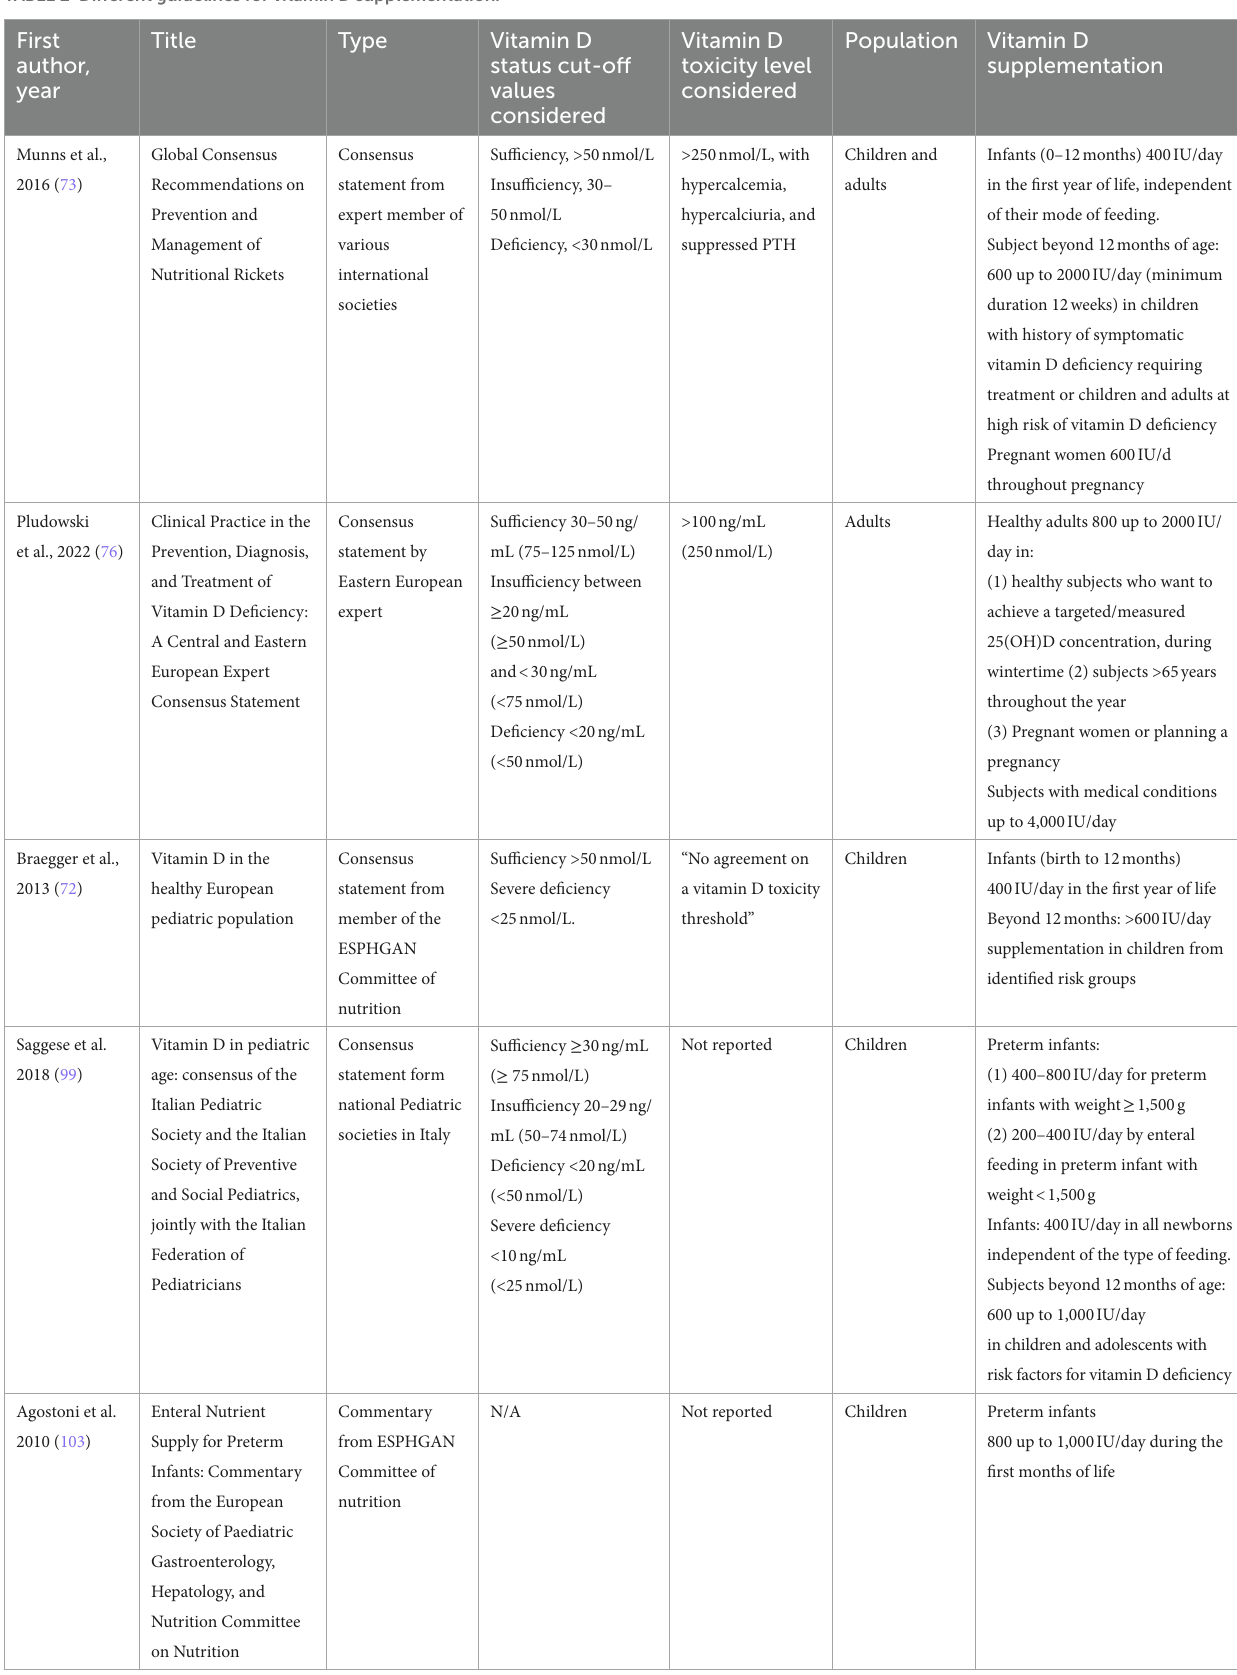
TABLE 2 Different guidelines for vitamin D